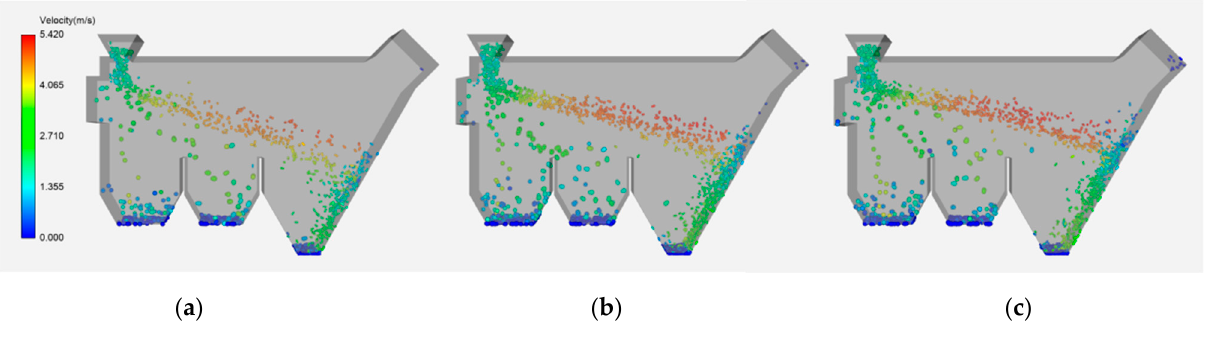
Figure 13. Particle motion of different types of airflow inclined angles: ( a ) 0°; ( b ) 7.5°; ( c ) 15°.